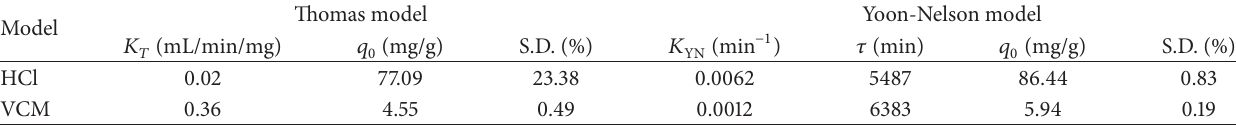
Table 5: Calculated column kinetic parameters for HCl and VCM adsorption on 6N